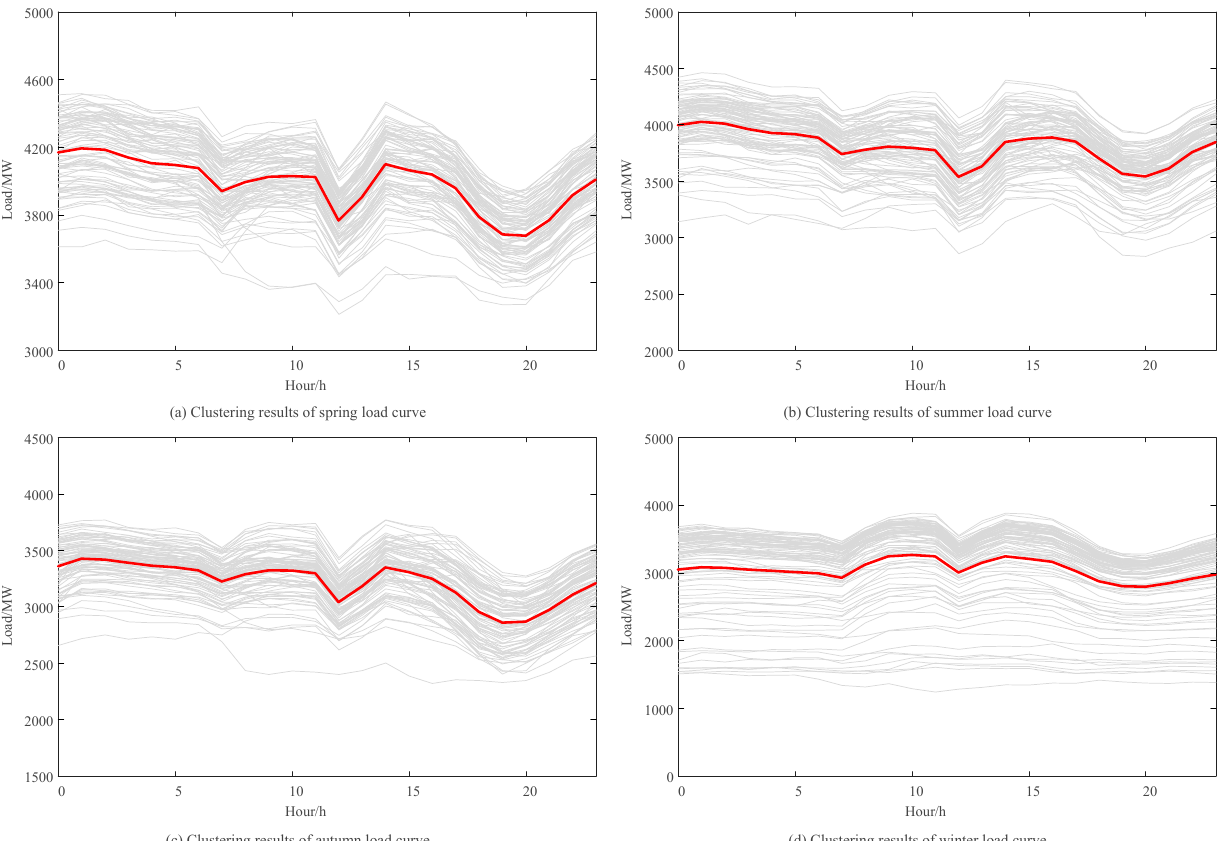
4.2. Clustering of Typical Daily Load Curves in Four Seasons based on K-Means++ Algorithm The clustering of typical daily load curves in four seasons is shown in Figure 2.